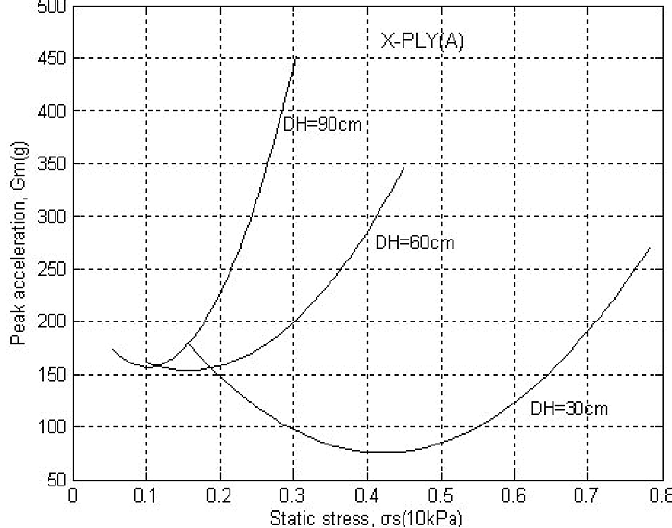
Fig. 5. Dynamic cushioning curves of X-PLY(A) corrugated paperboard.